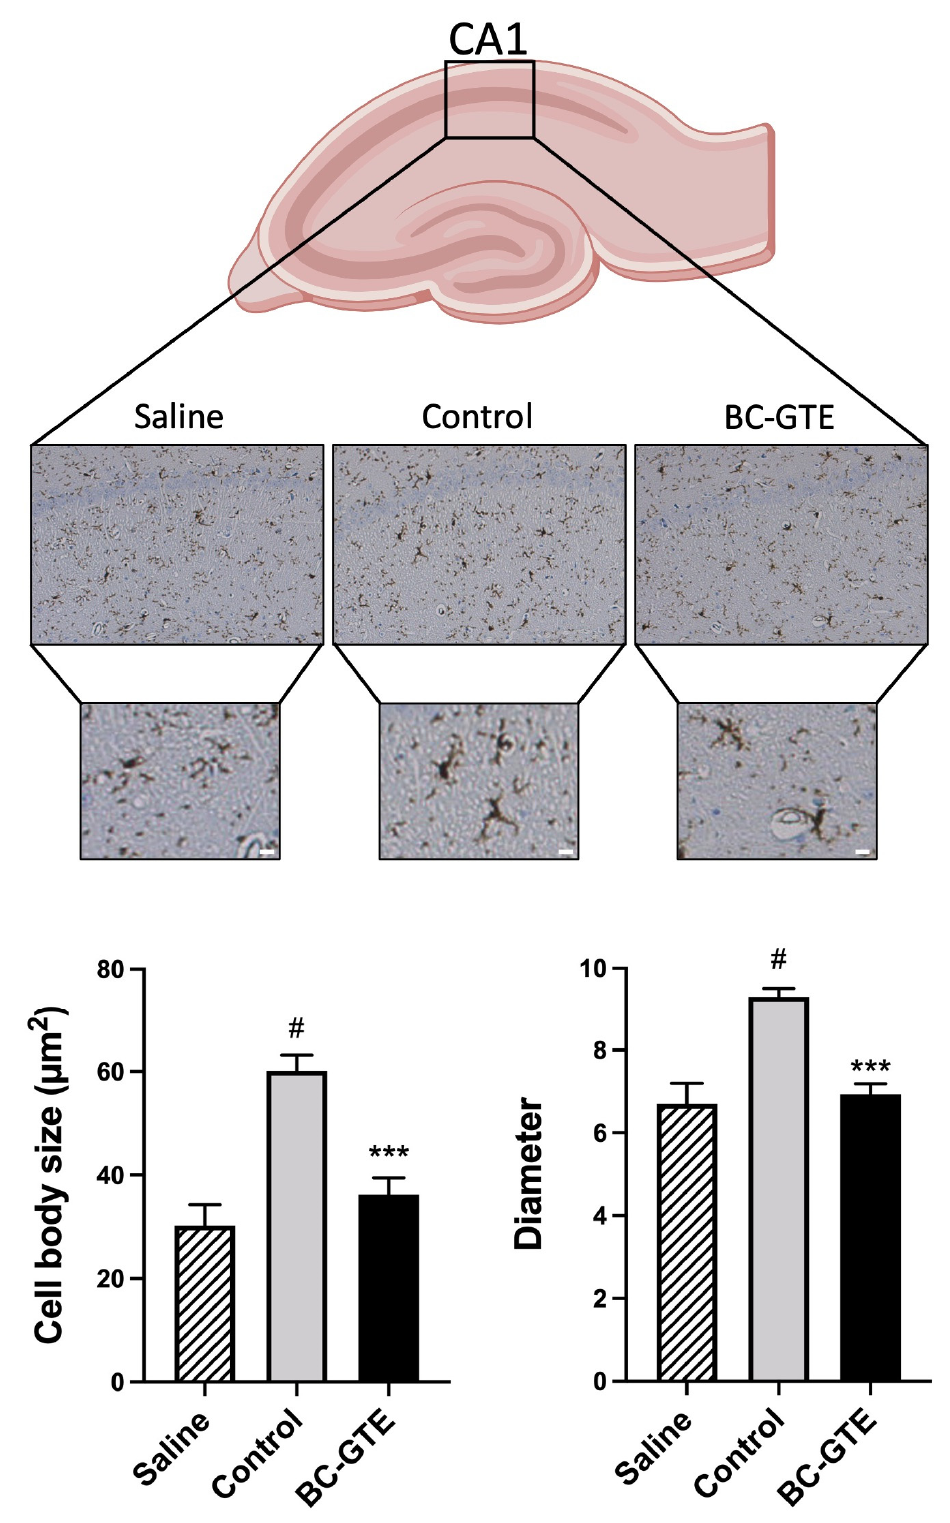
Figure 3. Experimental data presenting the physiological e ff ects of BC-GTE on LPS-induced adult rats. The microglial cell body swelling (B, C). Abbreviations: BC-GTE—extract treated animal group; (***) p < 0.001 control vs. BC-GTE group; ( # ) p < 0.01 control vs. saline group. The values are mean ± SEM, n = 30–60. Scale bar: 10 µm.